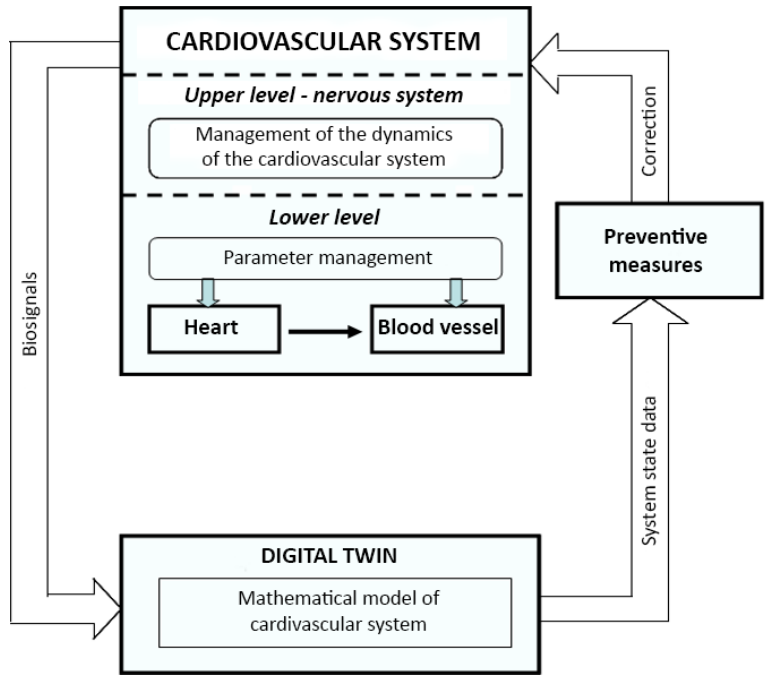
Fig. 5. The structure of the cyber-biological